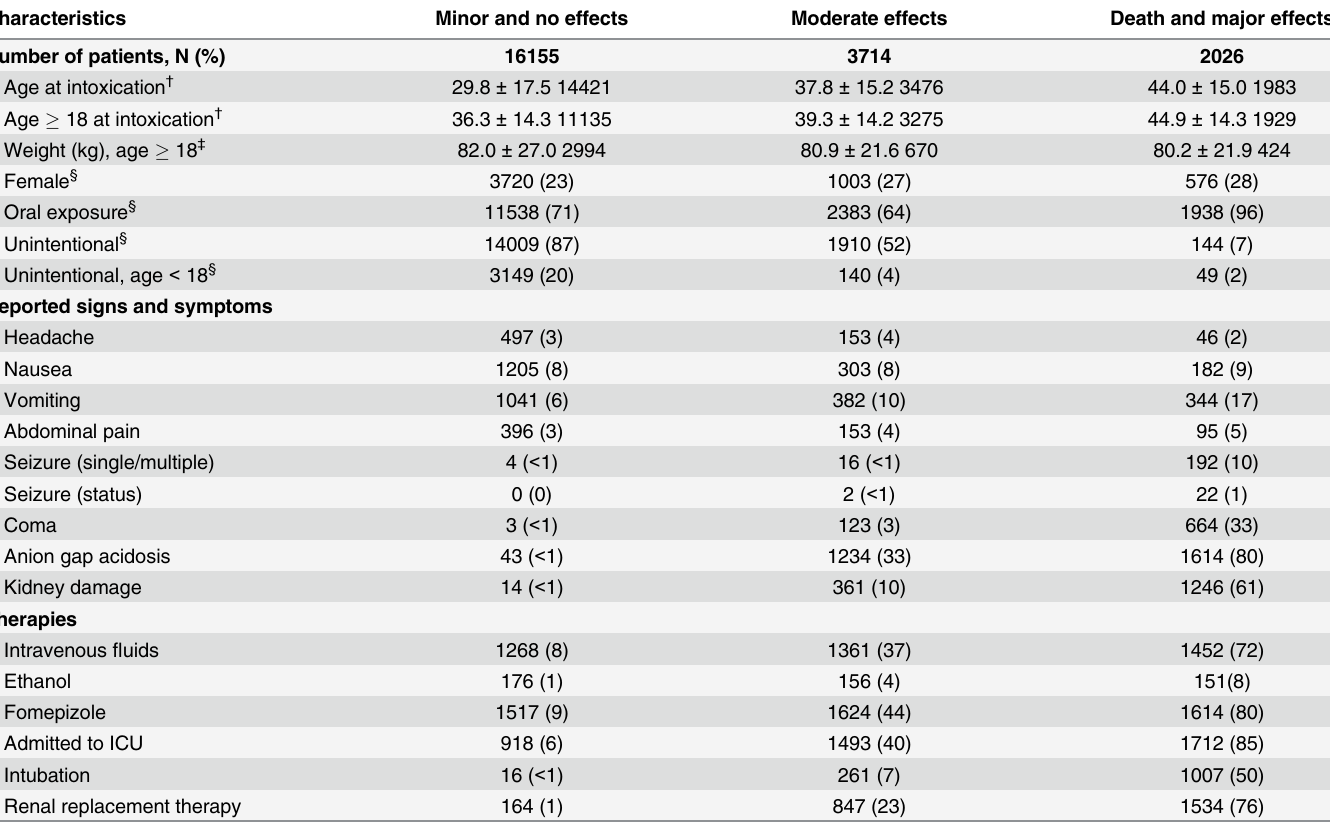
Table 2. Characteristics of Patients Who Experienced Effects Attributed to Ethylene Glycol Poisoning *